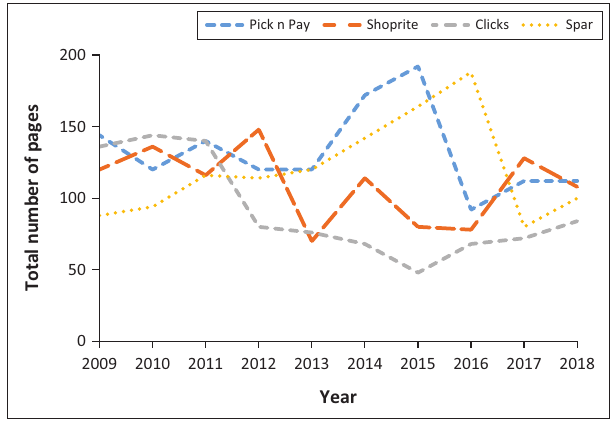
FIGURE 1: Number of pages in annual integrated reports from 2009 to